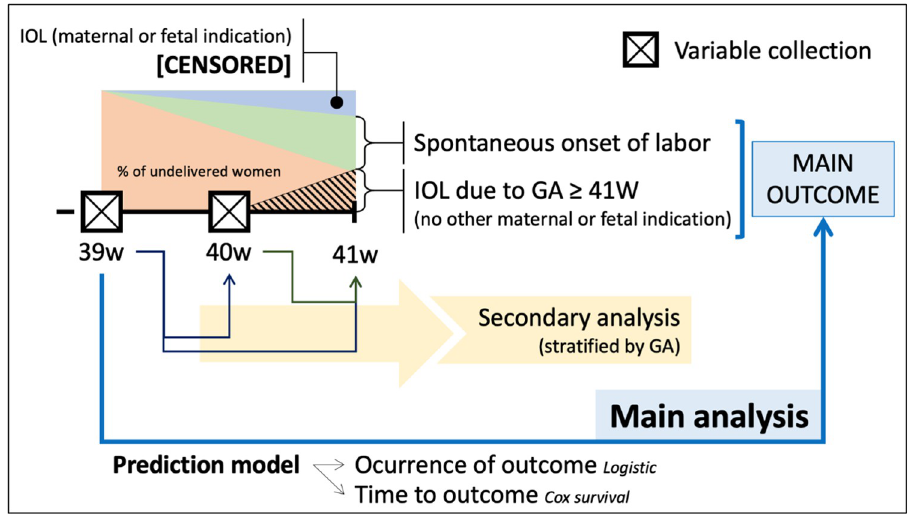
Fig 2. Study procedures. Scheme showing the different moments in which the potential predictors will be collected, as well as the outcomes and the planned analysis. A proportion of women will require IOL (or cesarean delivery) due to maternal or fetal indication and will be excluded from the logistic regression models (however considered as censored information for survival analysis). From the remaining cohort, some of them will go into spontaneous labor, while the others will be induced after 41 weeks of pregnancy due to gestational age. These last two groups will define the main outcome. As information will be also collected at 40w, a secondary analysis, stratified by gestational age, will be performed. IOL, induction of labor; w, weeks of pregnancy; GA, gestational